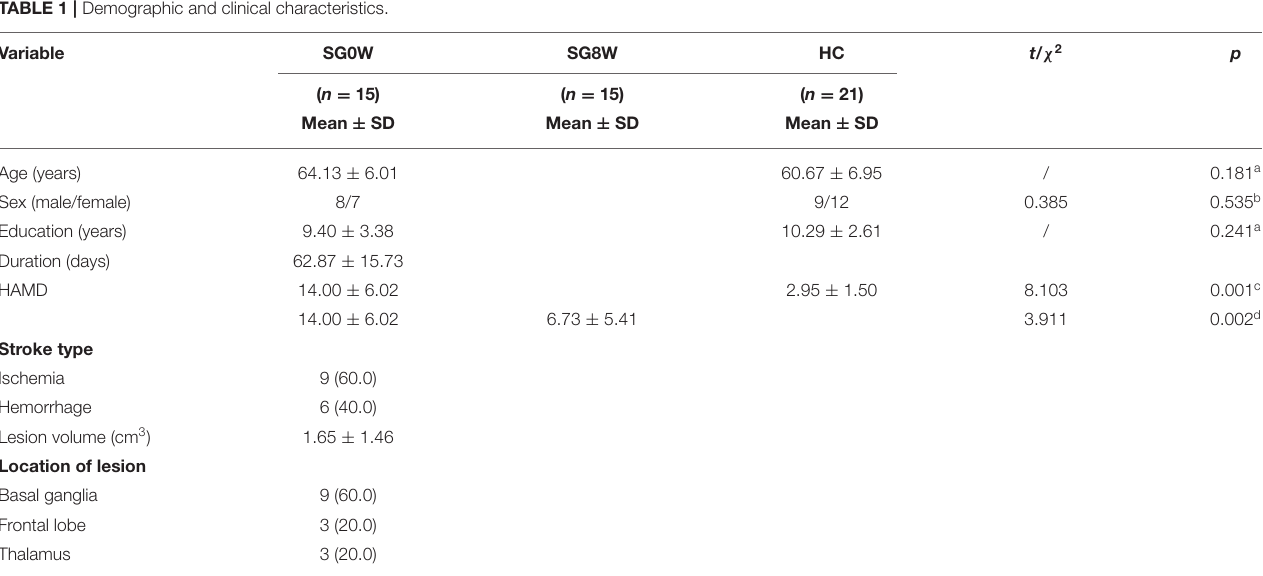
TABLE 1 | Demographic and clinical characteristics.